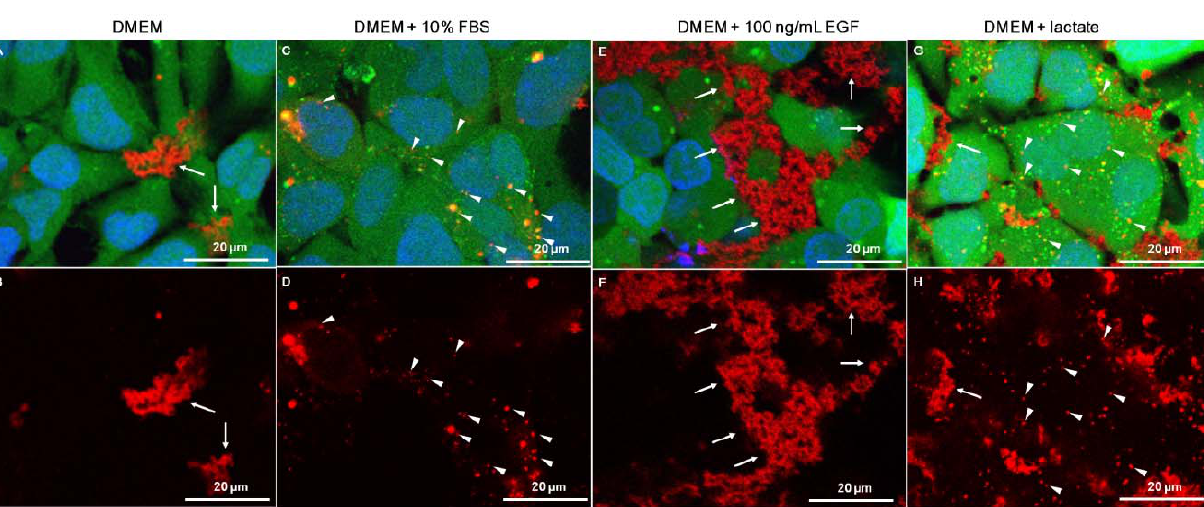
Figure 12. Confocal images of HEK293 cells exposed to RITC-80M chitosan pipetted into media pH 7.4 ( A – F ) or lactate-acidified media pH 6.5 ( G – H ). Top panels: calcein AM (green live cells), Hoechst 33342 (blue cell nuclei) and RITC-80M chitosan particles (extracellular, white arrow; vesicle, arrowhead). Bottom panels: RITC-chitosan-only. Arrows: extracellular chitosan. Arrowheads: intracellular